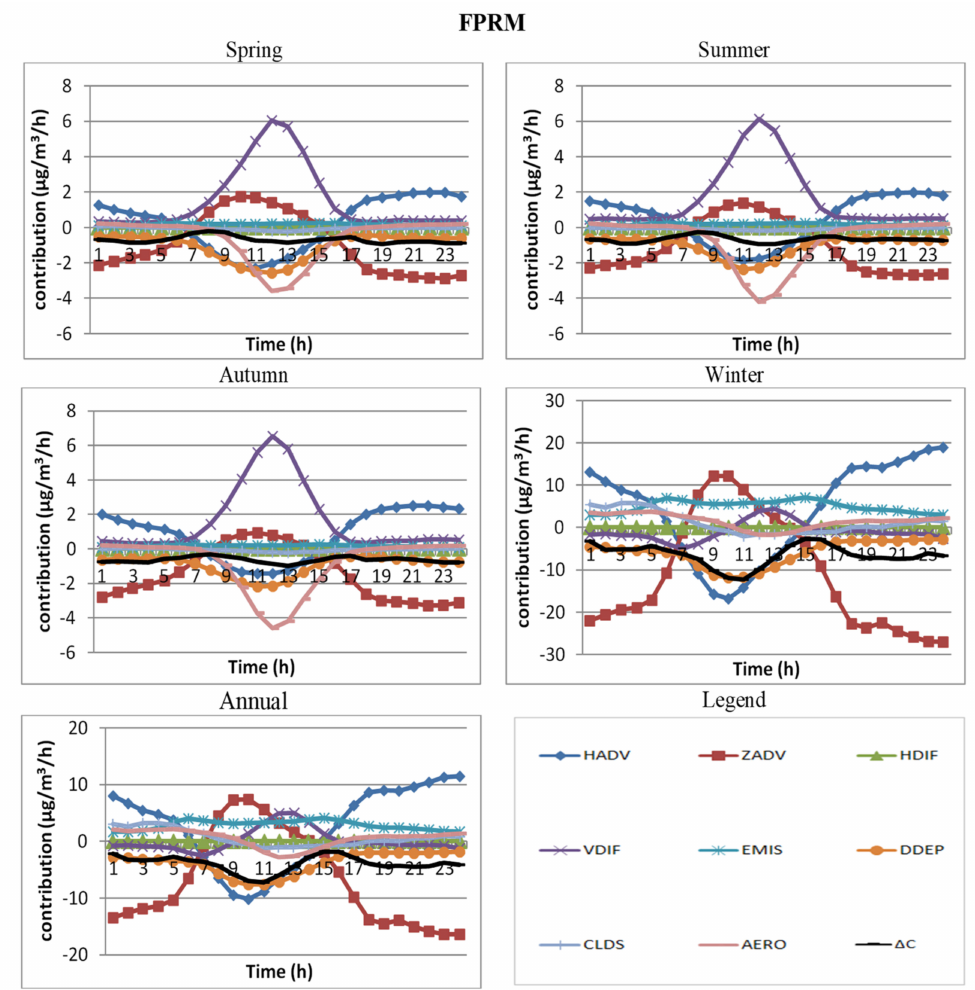
Figure 7. Annual, seasonal and diurnal course of the contribution of the different dynamic and chemical processes for the formation of FPRM concentrations ( µ g/m 3 /h) averaged for the territory of Sofia for the period